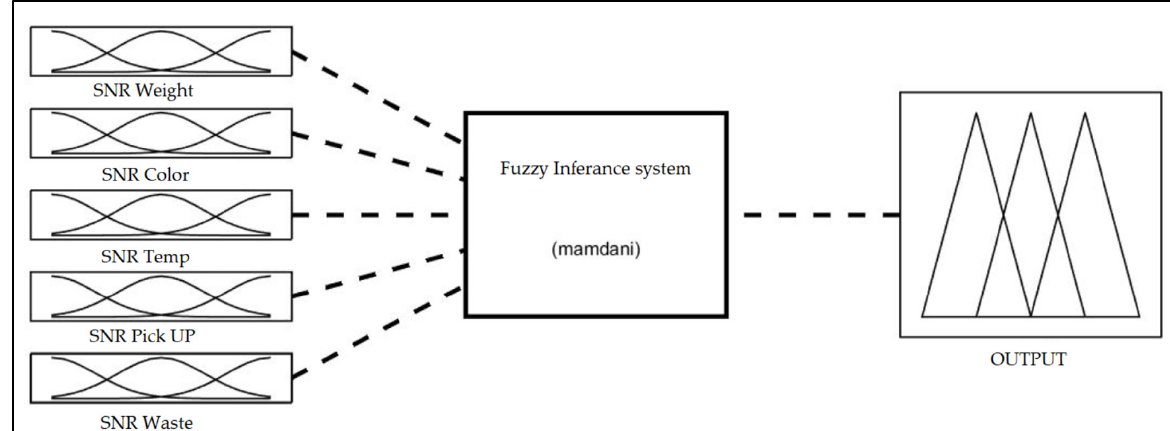
Figure 5. The inputs in the fuzzy system.